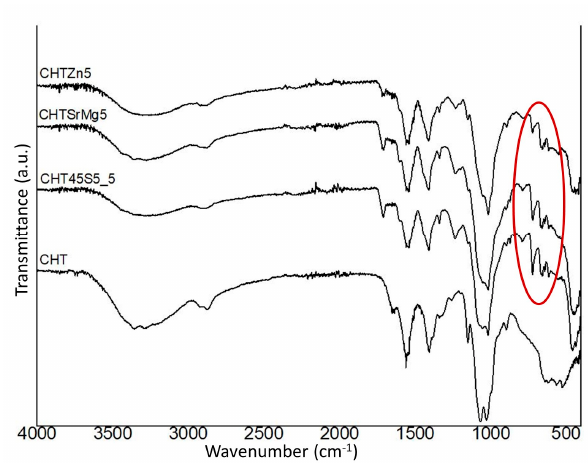
Figure 2. FTIR spectra of CHT, CHT45S5_5, CHTSrMg5, and CHTZn5 wound dressings. Si–O–Si stretching and Si–O–Si bending are highlighted in red.